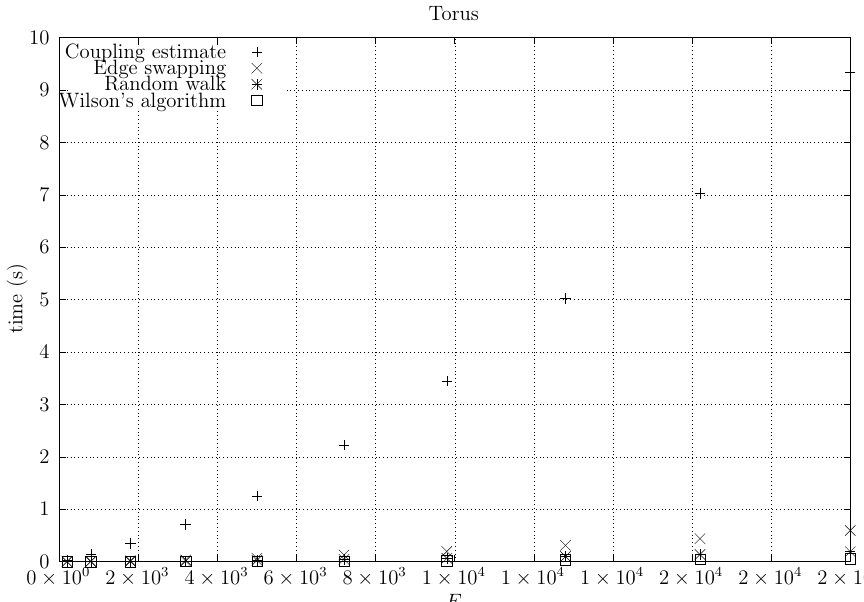
Figure 30. Running times for square torus graphs averaged over five runs, including the running time for computing the optimistic coupling estimate, the running time for generating a spanning tree based on that estimate, the edge-swapping algorithm, the running time for generating a spanning tree through a random walk, and the running time for Wilson’s algorithm.